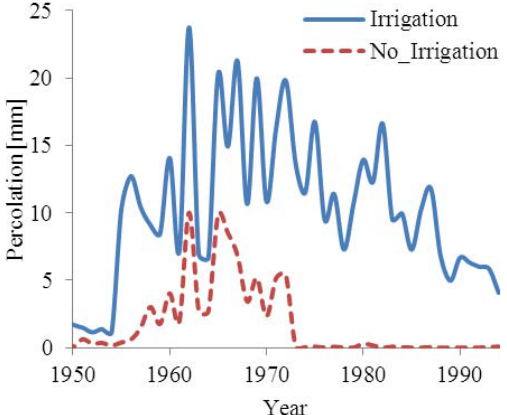
Fig. 7. Soil profile percolation for non-irrigation and irrigation cases.